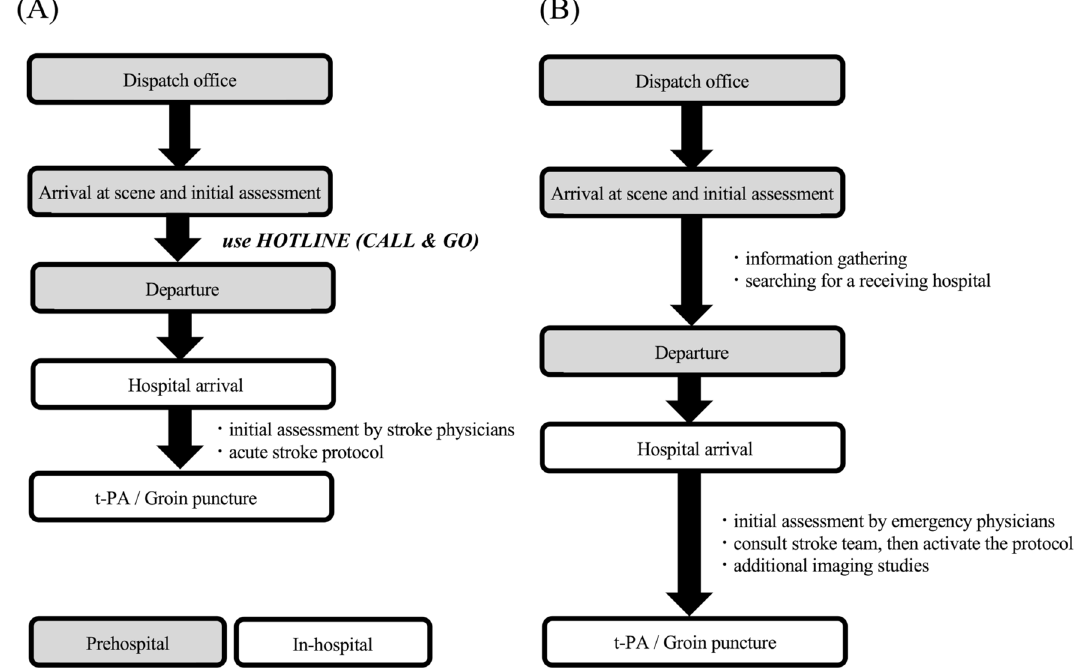
Figure 1. Time courses in management of large vessel occlusion patients with or without using a stroke hotline. ( A ) When emergency medical services (EMS) suspected a patient of having a stroke, the stroke hotline allows the EMS to depart the scene as soon as possible, and they do not need to spend their time searching for a receiving hospital. Medical staff in the hospital are also able to prepare tissue plasminogen activator (t-PA) and endovascular therapy (EVT) based on the prehospital information. Furthermore, we have developed a stroke protocol to shorten the time from the patient’s arrival to stroke treatments. ( B ) When a patient is not suspected of having a stroke, the EMS need to spend their time at the scene searching for a receiving hospital, leading to a longer prehospital time. Further, after arriving at the hospital, the stroke protocol is not activated until emergency physicians complete their initial assessment of the patient and consult a stroke physician. Consequently, it often takes longer from arrival at the emergency department to undergoing initial stroke